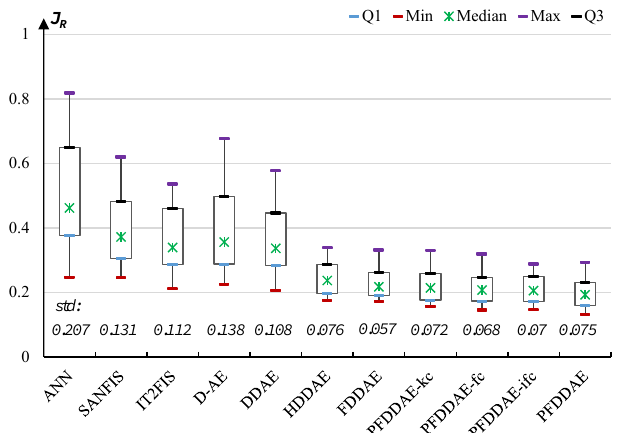
Figure 8. The performance (in terms of regression error) of the comparative models for cyborg flight behavior